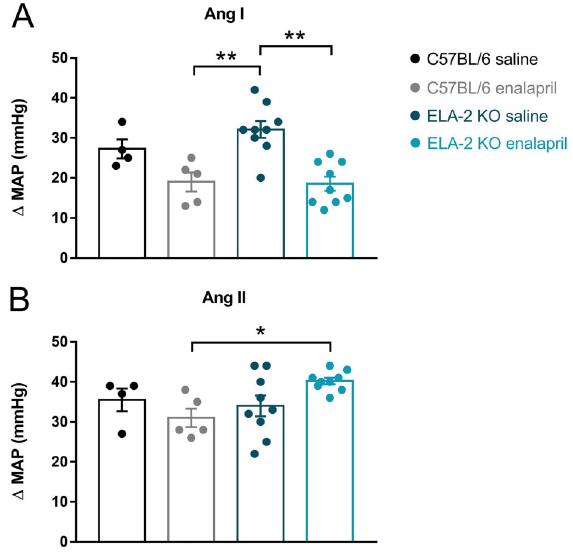
Figure 1. Mean arterial pressure variation ( D MAP) after angio- tensin I (Ang I) ( A ) and angiotensin II (Ang II) ( B ) administration in knock-out mice (ELA-2 KO) and wild-type mice (C57BL/6) treated with saline or enalapril. Data are reported as means ± SE.